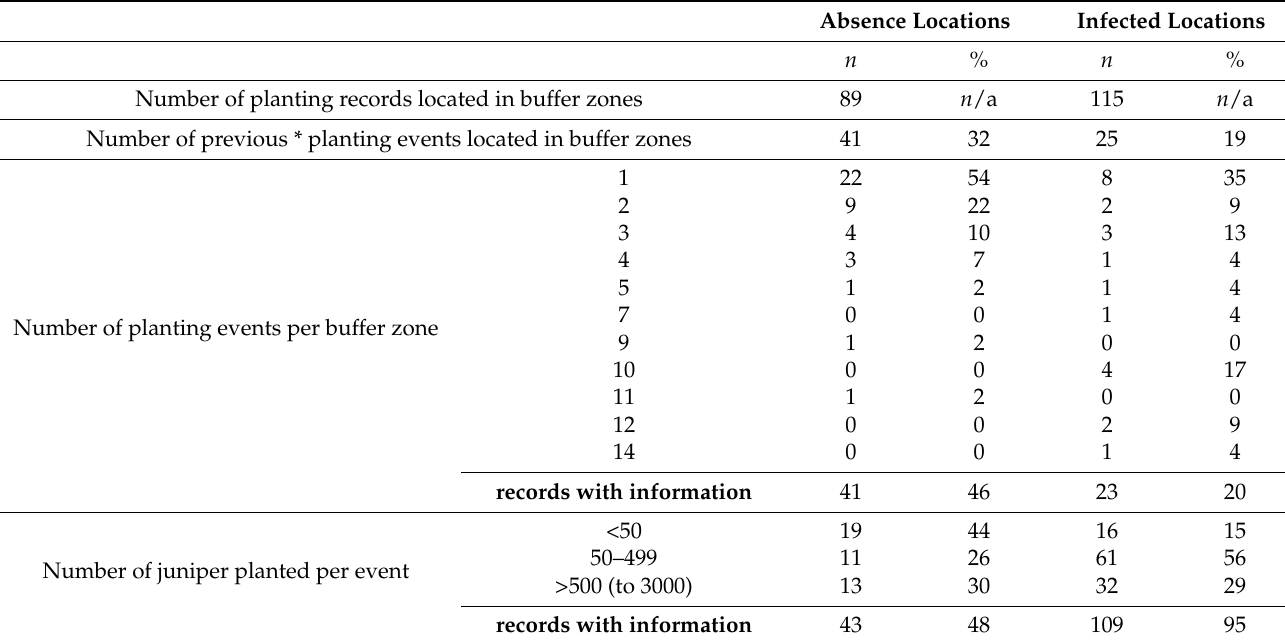
Table 2. Summary of the total number ( n ) of planting records, total number and percentage (%) of planting events, numbers and percentages of planting events and of juniper planted per event found in the 500 m radius buffer zone surrounding 130 P. austrocedri absence and 130 infected locations, selected as the minimum distance to a planting event per 1 km grid cell (monad). Planting events refer to planting carried out at a location in a specific year that could be documented by one or more planting records. * Records were extracted where planting events took place before, or in the same year, as visit or